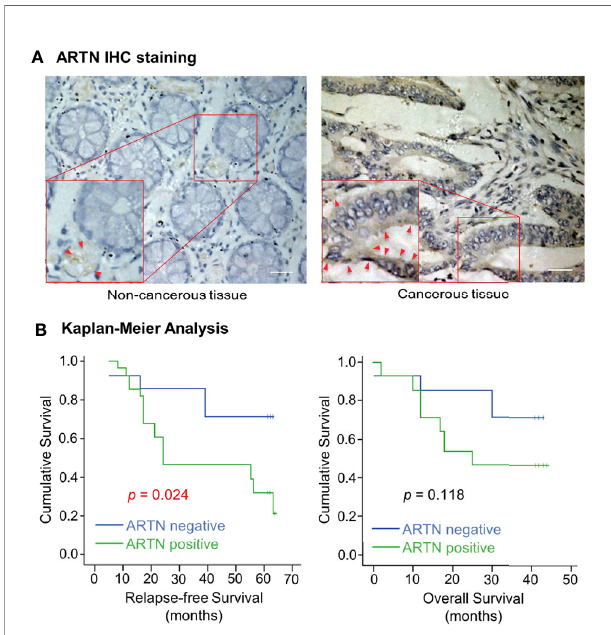
FIGURE 1 | Increased expression of ARTN in CRC is associated with poor prognosis. (A) Immunohistochemical analysis of ARTN protein expression in non-cancerous colorectal tissue (left) and colorectal carcinoma tissue (right). Original images were taken at the magni fi cation of X200 under a microscope. The indicated areas (red rectangular) were enlarged for staining details. The red arrowheads indicate the positive staining for ARTN. (B) Kaplan – Meier analysis of the correlation of the immunohistochemistry-determined ARTN protein expression to relapse-free survival (left) and overall survival (right) of colorectal carcinoma patients. Data were collected from 42 out of 89 colorectal carcinoma